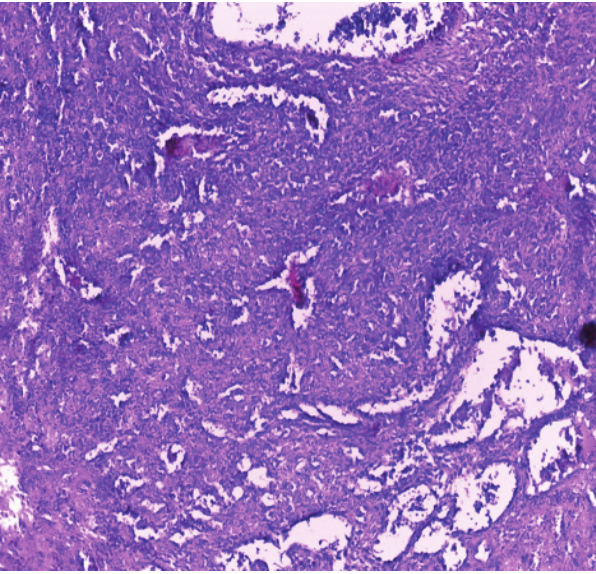
Figure 5. Microscopie view: vessels of variable size dissociating fibro- collagenous tissue.